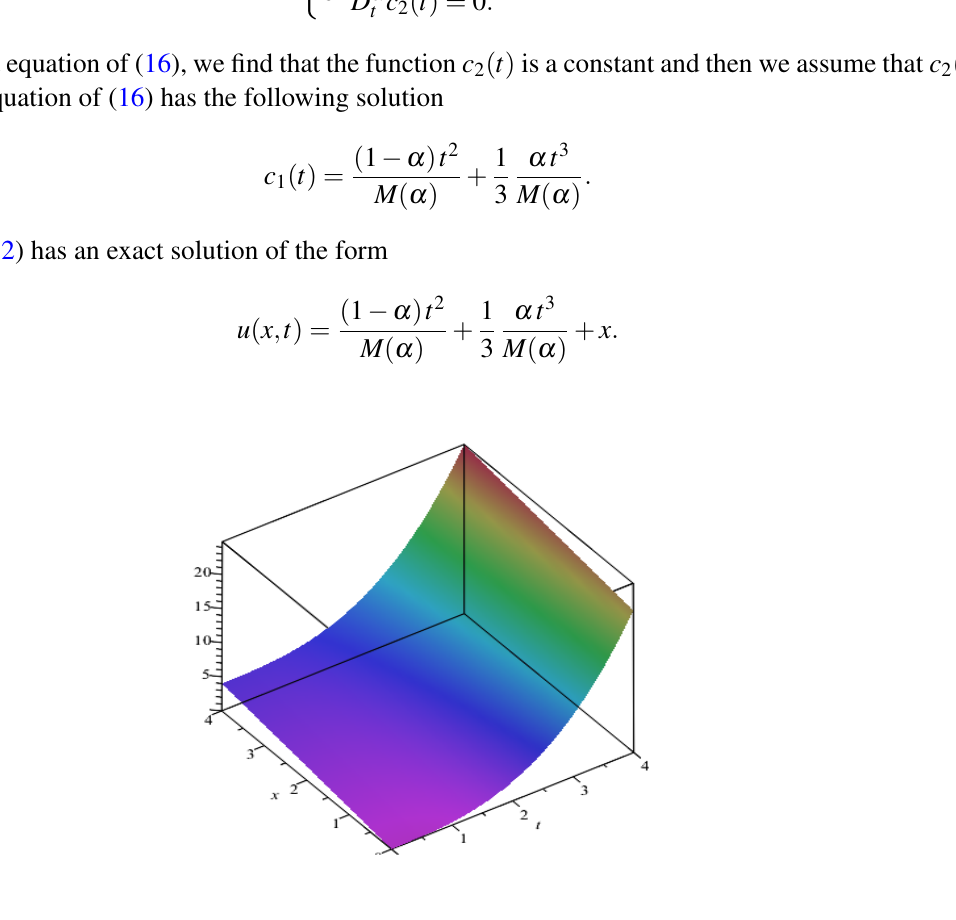
Fig. 1 Profile of the solution (18) for α = 0 . 9